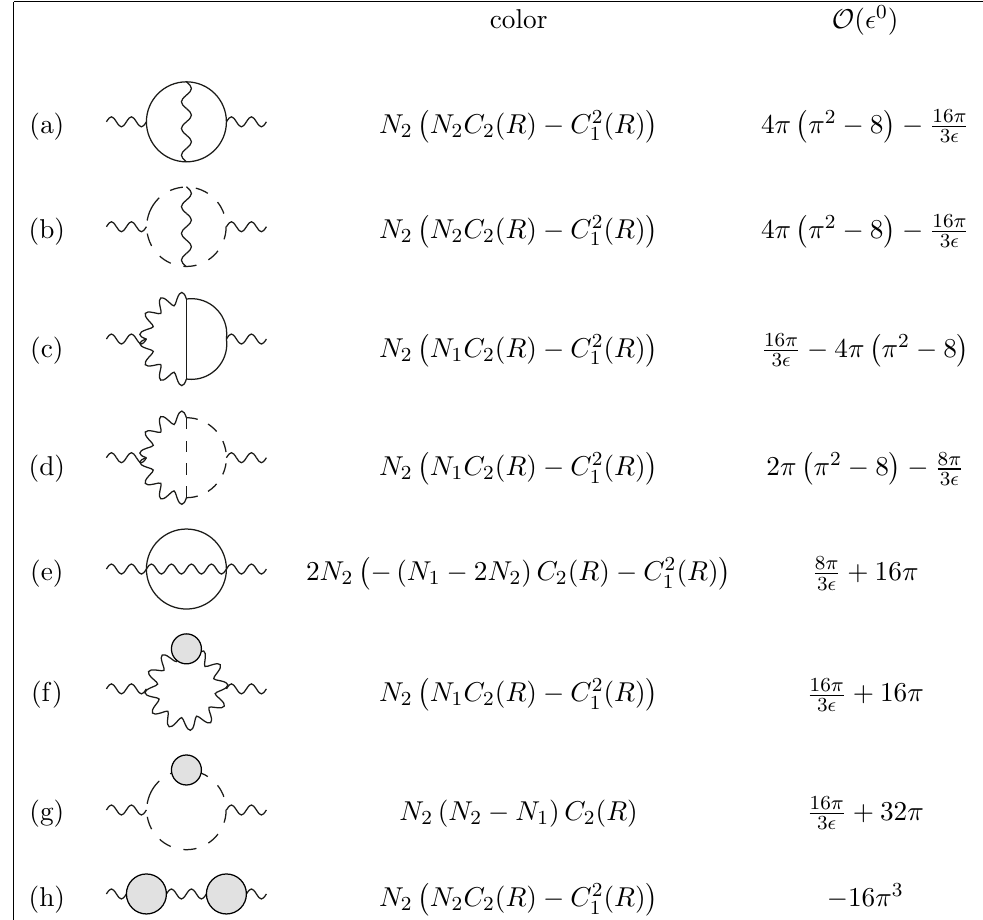
Table 1. Table of non-vanishing self-energy diagrams with matter